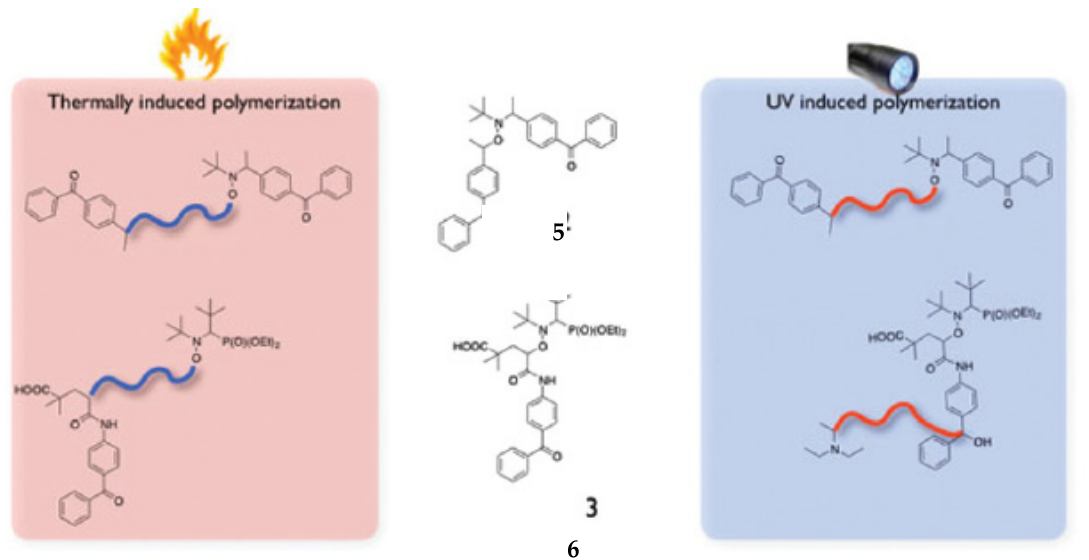
Figure 6. The two different polymerization modes that could be used with 5 and 6 . An amine is used as co-initiator for UV-induced polymerization with 6 . Reprinted with the permission of RSC from ref. [56] NMP2 is now an e ffi cient approach for lithography [57]. It has also found many applications in materials science (Figure 7) [55,56].